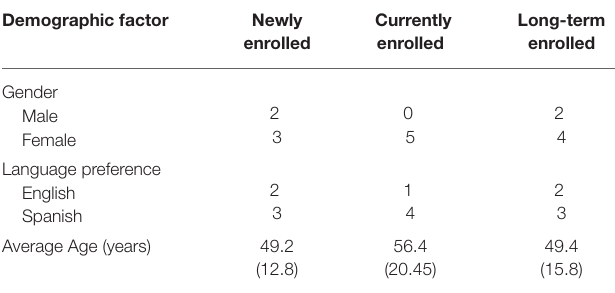
TABLE 2 | Demographics by levels of engagement. Demographic